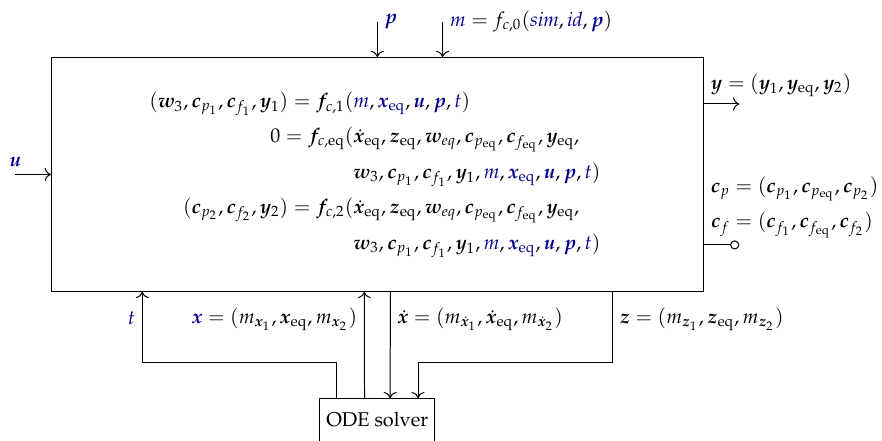
Figure 3. Description of an acausal built-in component with functions of a programming language that has internal memory and with the same interface as in Figure 1. m = f c ,0 ( sim,id, p ) is an instance of the built-in component. It is constructed before simulation starts given a reference to the simulation engine sim, a unique identification id of the instance, and the parameters p . The hidden state derivatives m ˙ x are computed in f c ,1 and m ˙ x in f c ,2 . In some cases, (new) local, algebraic 2 1 variables w 3 need to be introduced to hide, e.g., state variables in f c ,eq